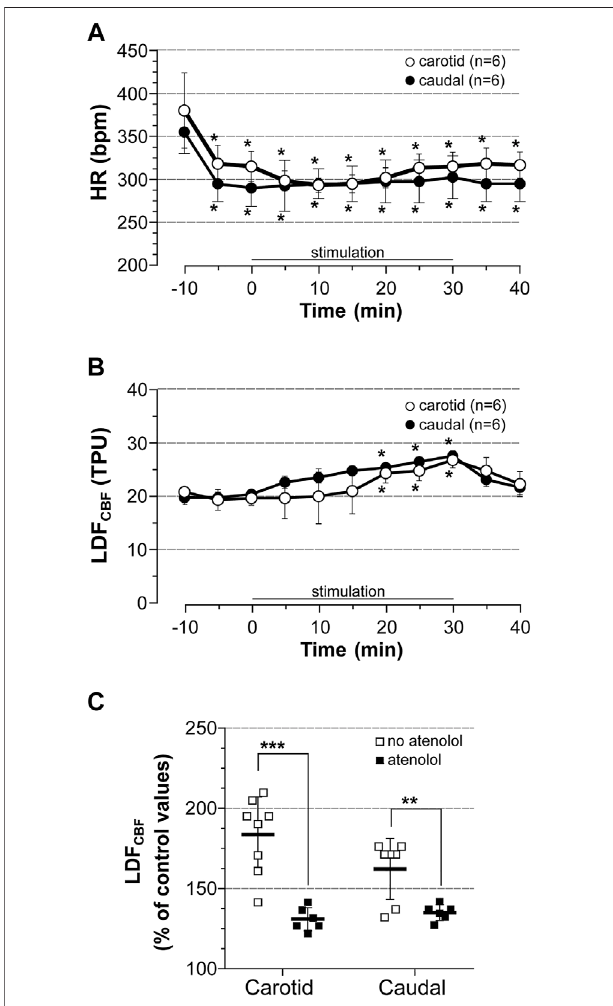
FIGURE 4 | Cardiovascular effect of induced contraction in atenolol- treated rats. Atenolol (10 mg/kg, i.v.) was administrated 10 min before (time -10) bilateral hindlimb contraction at 5x motor threshold. (A) HR was calculated from BP trace that was recorded from the common carotid artery (carotid series) or the caudal artery (caudal series), (B) LDF CBF was measured in the cortical area representing the hindlimb, (C) Difference in CBF expressed as % of control values at 30 min of stimulation in rats treated with atenolol (full squares) vs . untreated rats (empty squares). Values are expressed as means ± SD, n = number of rats. * signi fi cantly different from pre-stimulation values at p < 0.01 and no difference between series after two- way (time x group) ANOVA and Bonferroni